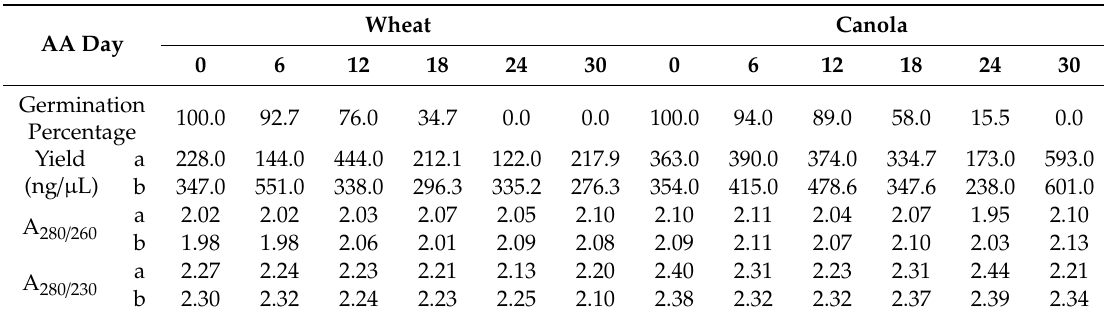
Table 1. Extracted total RNAs from the unaged and acceleratedly aged (AA) seed samples of wheat and canola seeds.